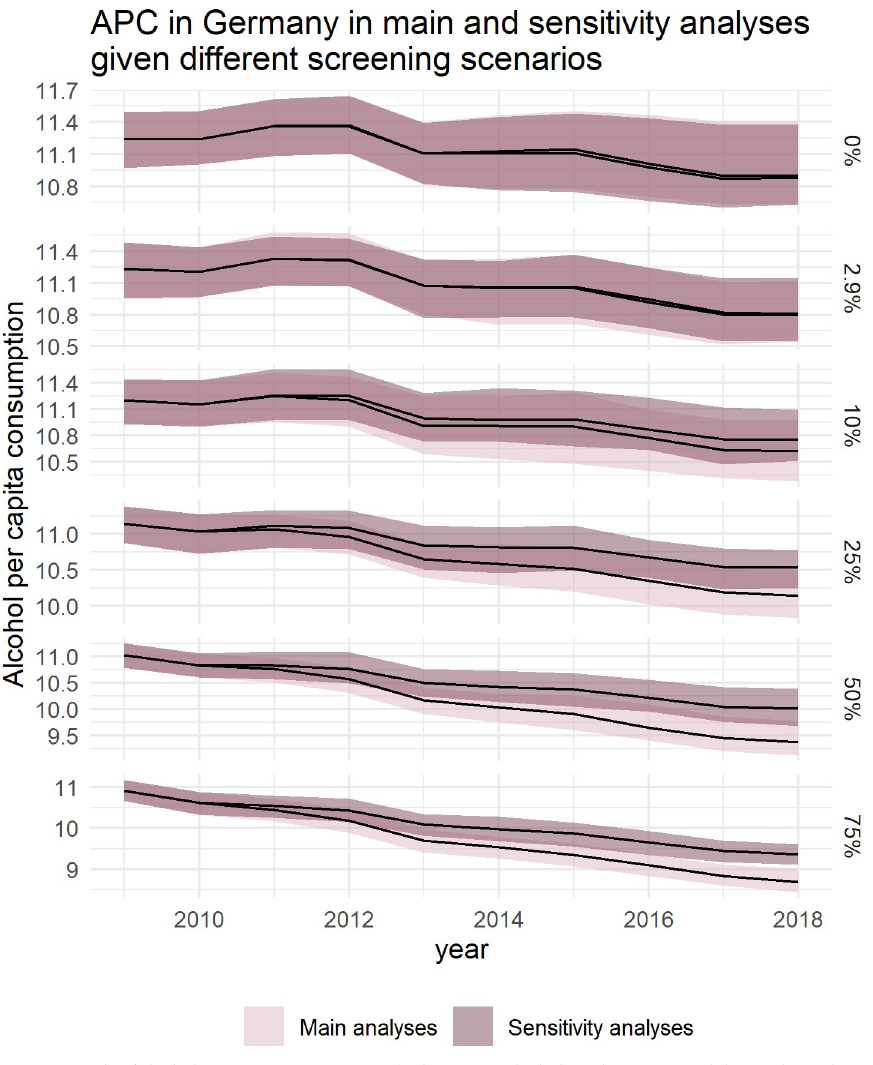
Fig 6. Trends of alcohol per capita consumption (in litres pure alcohol) in the German adult population between 2009 and 2018, by annual screening coverage (indicated at the